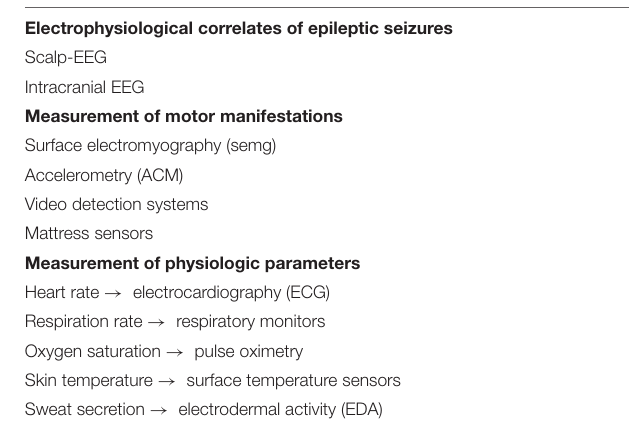
TABLE 1 | Measurement parameters for automatic seizure